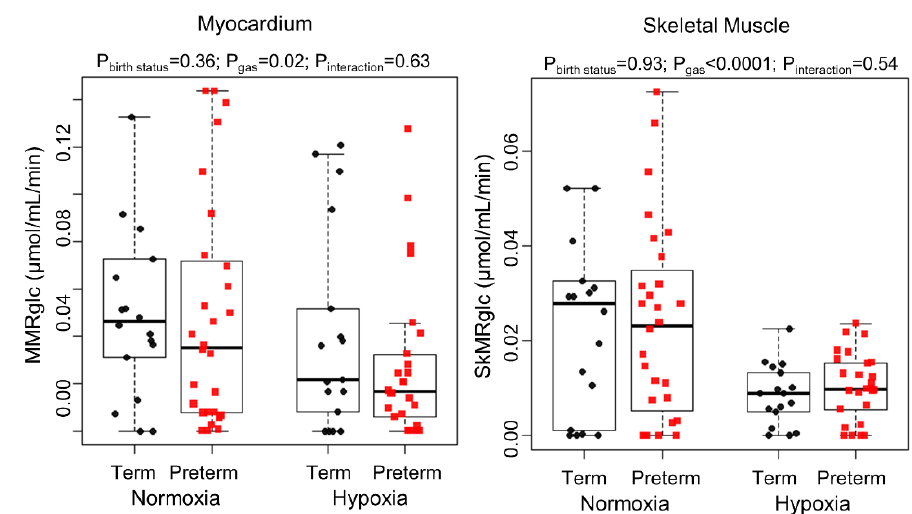
Figure 5. Dynamic PET measurements of the myocardial metabolic rate of glucose (MMRglc; left graph) and the skeletal muscle metabolic rate of glucose (SkMRglc; right graph). p -values listed at the top of the graphs are from linear mixed-effects models.